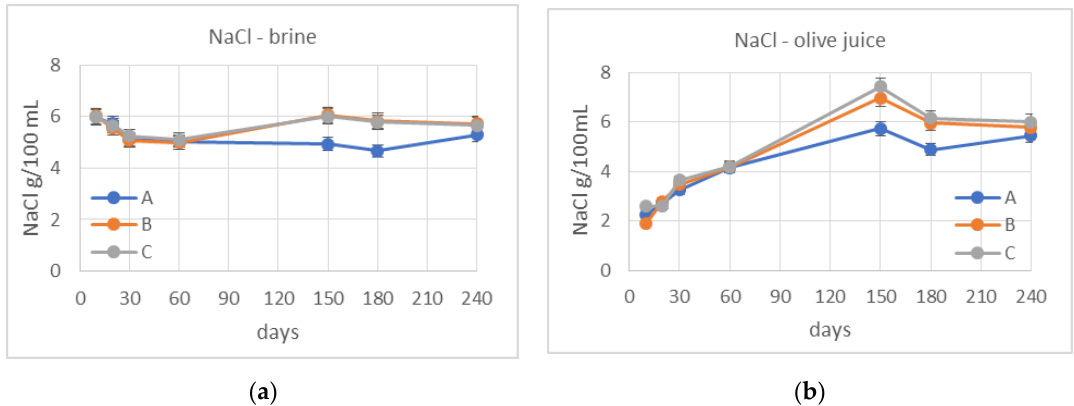
Figure 6. Evaluation of NaCl concentration in the brine ( a ) and in the olive juice ( b ) during fermentation. A = spontaneous; B = inoculated with L. plantarum B1; C = inoculated with L. plantarum B1 + B51 + B124. The data are expressed as the mean of two replicates ± standard deviation.